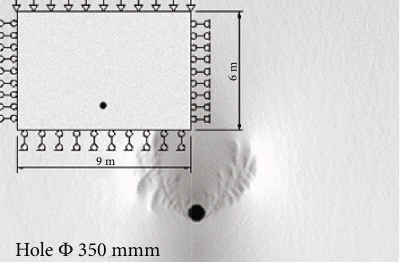
Figure 13: Maximum principal stress for 350-mm holes.